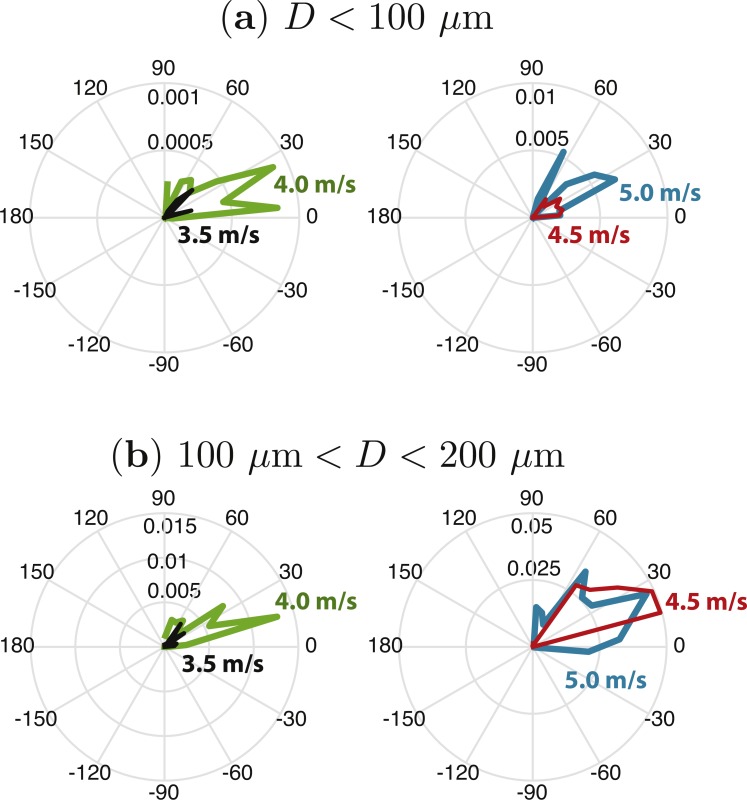
Momentum flux as a function of angle for droplets with diameters (A) D < 100 µm and (B) 100 µm <D< 200 µm, at four wind speeds (U = 3.5, 4.0, 4.5, and 5.0 m/s at 2.5 cm height).The radial increments are measured in g m−1 s−2 rad−1. The total momentum flux for droplets with diameters D < 100 µm is 1.4 × 10−4, 6.8 × 10−4, 2.0 × 10−3, 4.8 × 10−3 g m−1 s−2 for the four wind speeds, respectively. The total momentum flux for droplets with diameters 100 µm < D < 200 µm is 1.7 × 10−3, 7.3 × 10−3, 3.5 × 10−2, 4.6 × 10−2 for the four wind speeds, respectively.